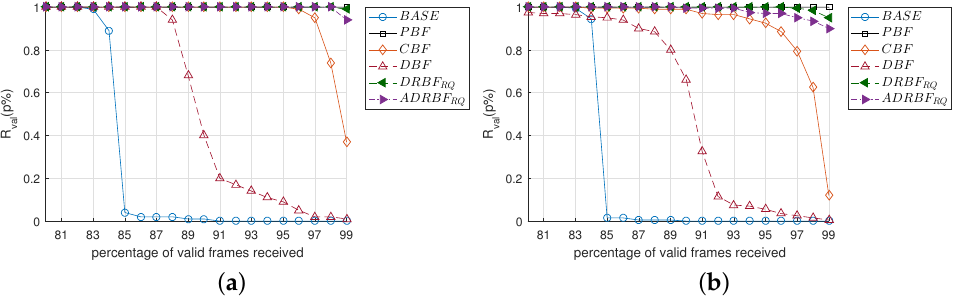
Figure 17. The comparison of flooding reliability in terms of R val ( n % ) when ( a ) the number of nodes is 100 and the network radius is 2 D tx , ( b ) the number of nodes is 200 and the network radius is 3 D tx